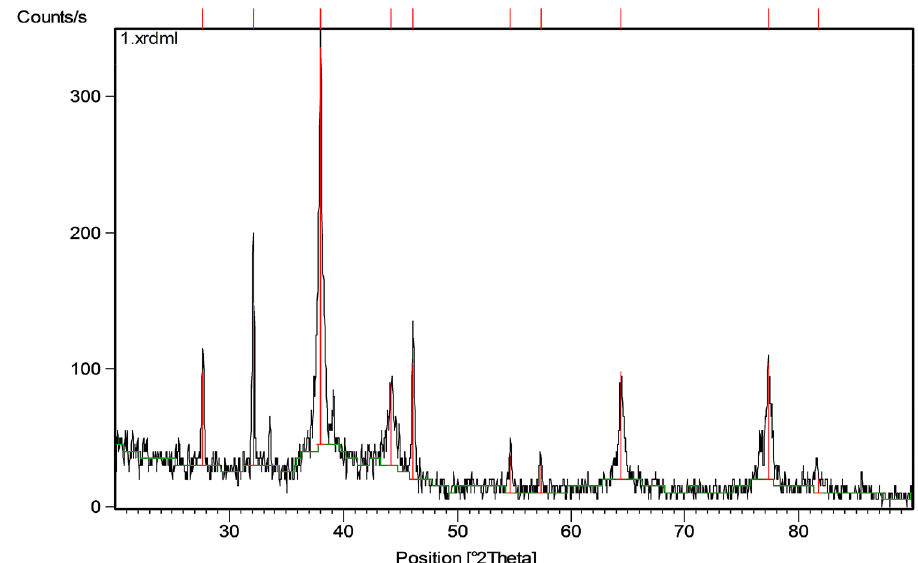
Fig. 2 AgNPs XRD pattern synthesized through green approach by M. wightii leaves extract